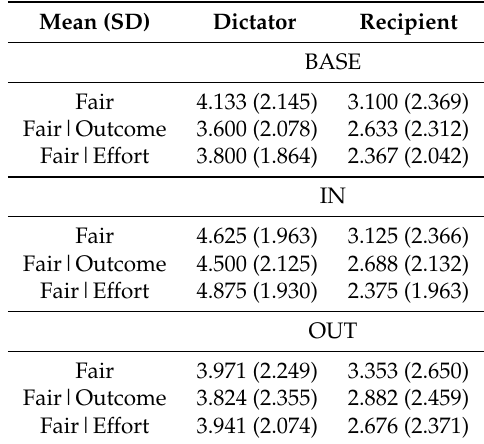
Table 3. Perception of